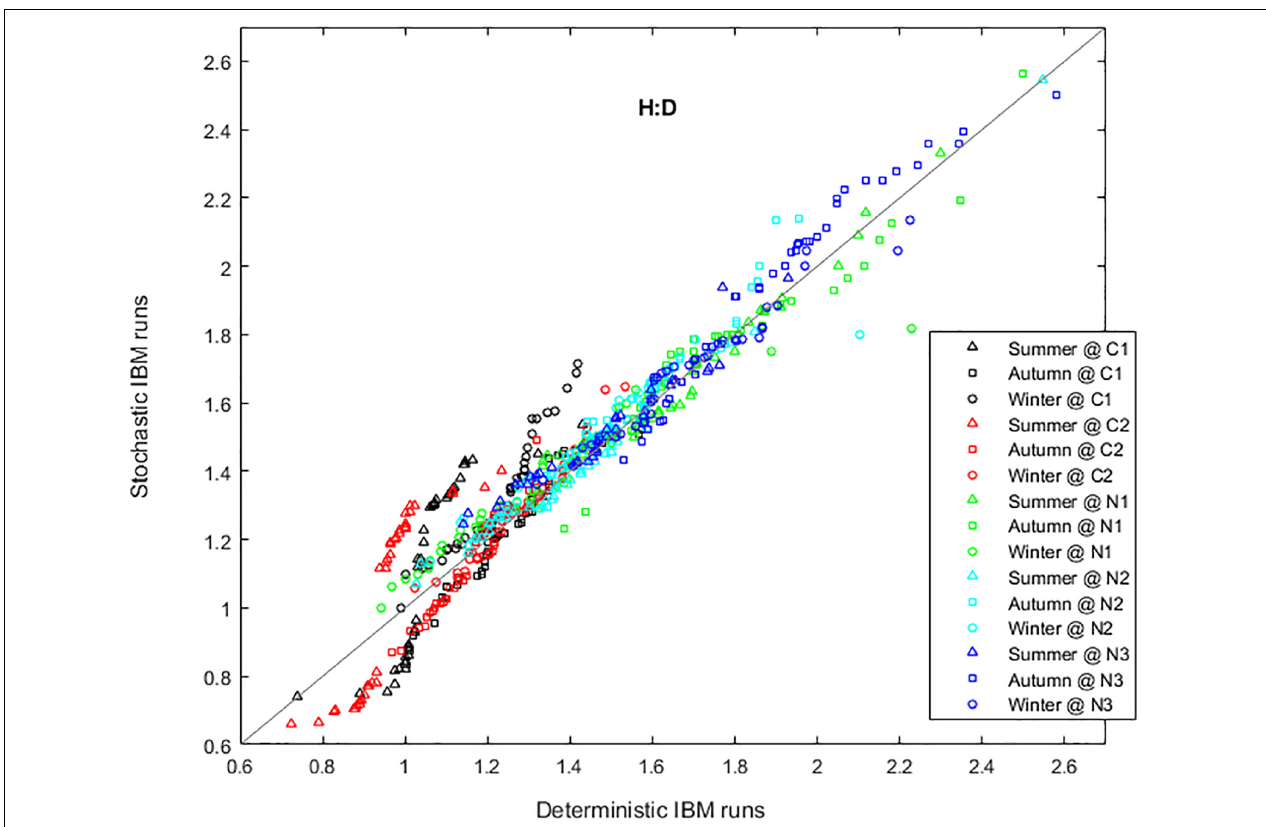
FIGURE 10 | Comparison between deterministic and stochastic runs of the IBM based on the forecasted haploid-to-diploid ratio (H:D) in plots Corral 1 (black), Corral 2 (red), Niebla 1 (green), Niebla 2 (light blue), and Niebla 3 (dark blue) during summer, autumn, and winter. Simulations of 20 years, starting October 2009. Simulations are stochastic or deterministic from February 2012